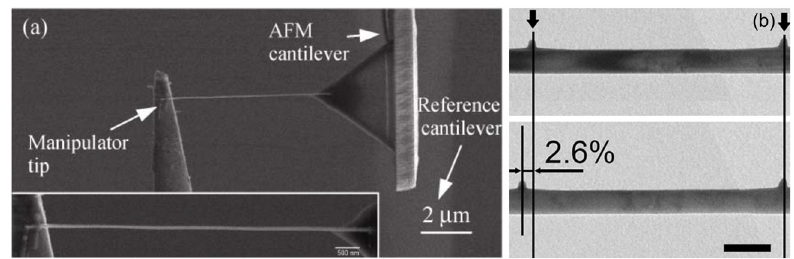
Figure 2: Examples of tensile tests carried inside SEM ( adapted form [ 41 ]) and TEM ( adopted form [ 40 ]) using piezo scanners.